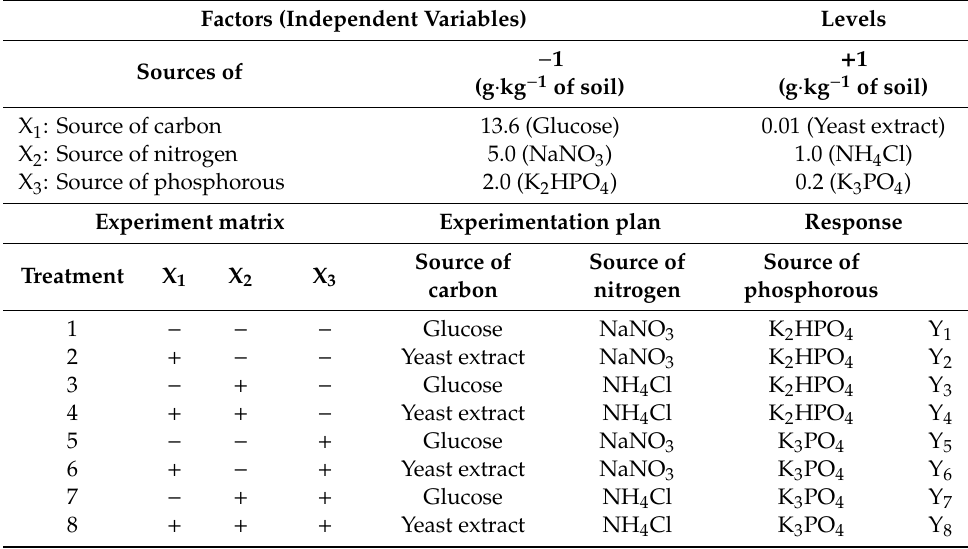
Table 1. Representation of factors and levels, the experimental matrix for the 2 3 factorial design, the experimentation plan, and the responses